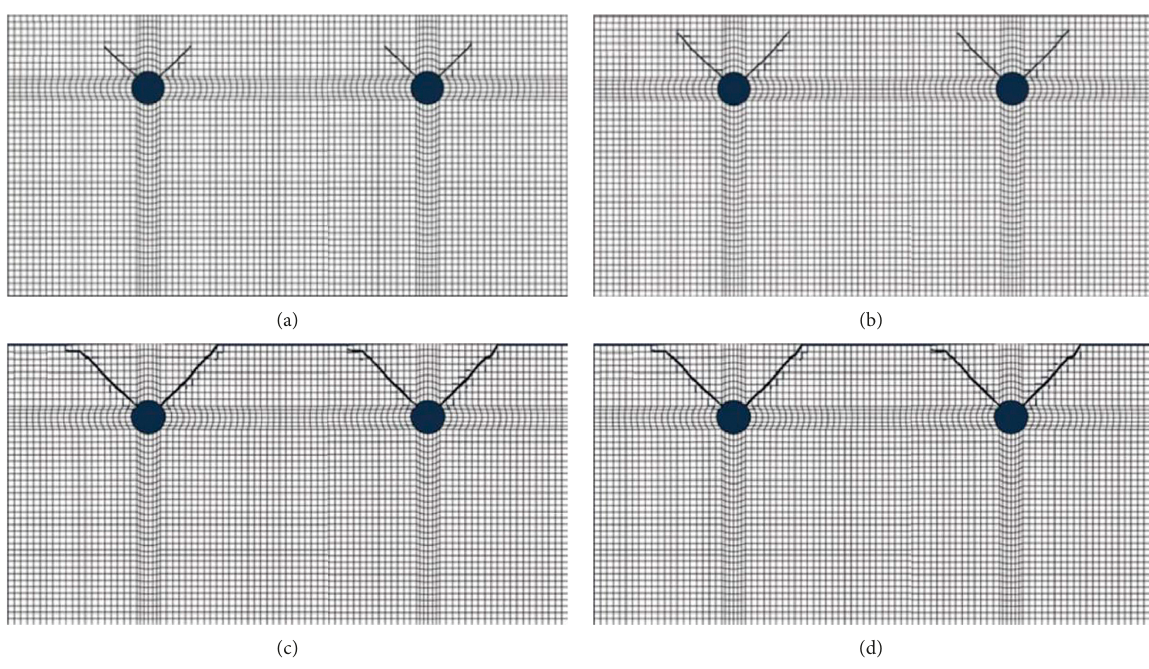
Figure 8: Concrete cover-cracking process when t � 19d (a), 37d (b), 152 d (c), and 642d (d) under nonuniform distribution of corrosion products.